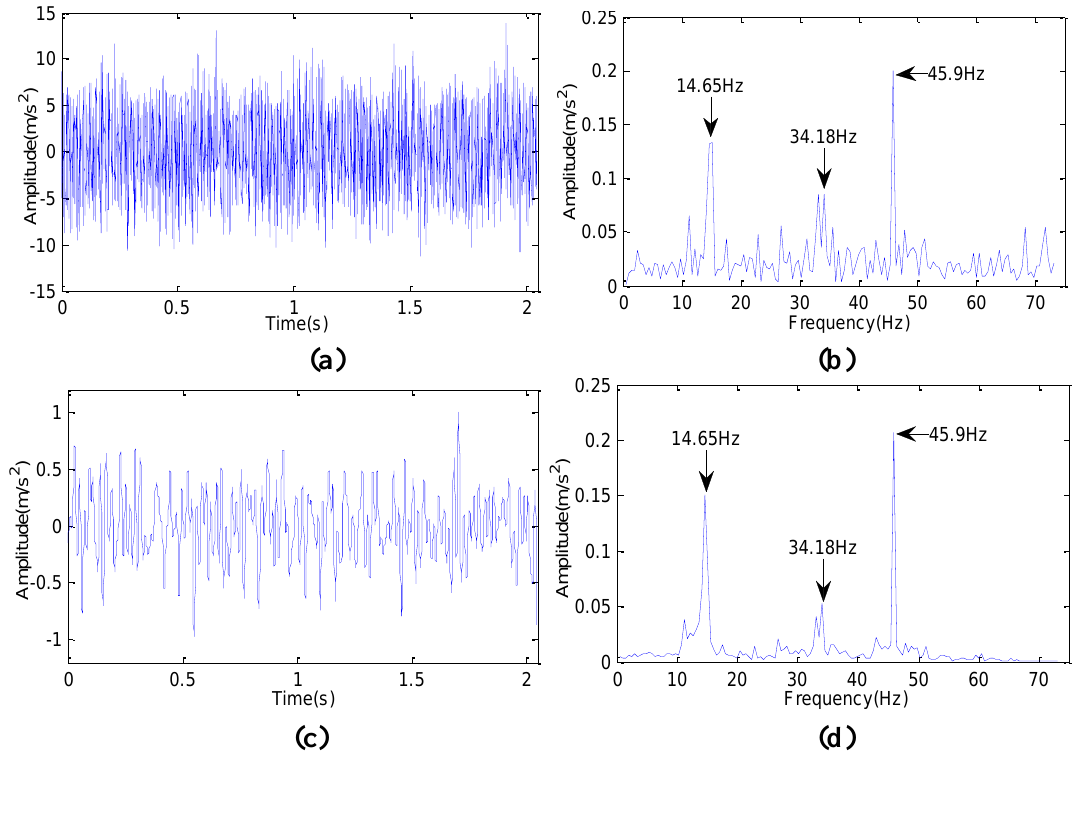
Figure 11. Comparison on the spectrum of Fourier Transform and wavelet lifting analysis of the original signals. (a) time domain waveform of the original signals; (b) spectrum of the original signals after Fourier Transform; (c) time domain waveform of approximation signal reconstruction after decomposition of wavelet lifting at level three; (d) spectrum analysis of wavelet